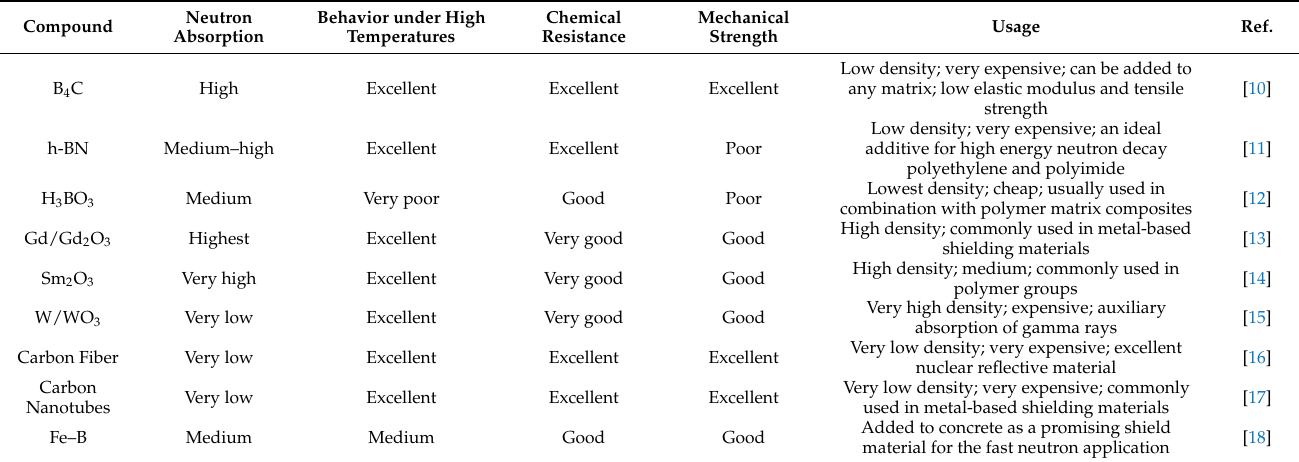
Table 2. Performance comparison of several main neutron-absorption